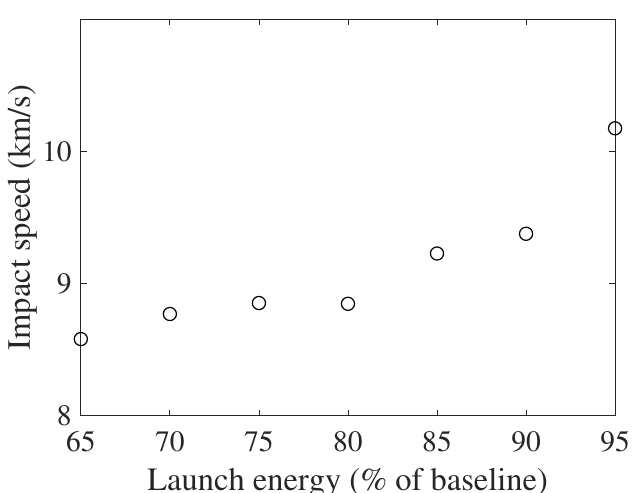
Figure 4. Variation of the impact speed with launch energy as a % of the baseline ( m prop = 150 kg, P source = 7330 W, and Φ =